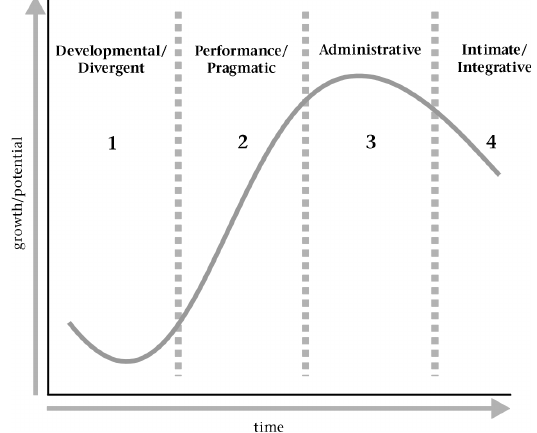
Figure 4: Organisation logic across life-cycle The four points of the scale used for question 46, along with the percentage distribution of responses from this study, are as